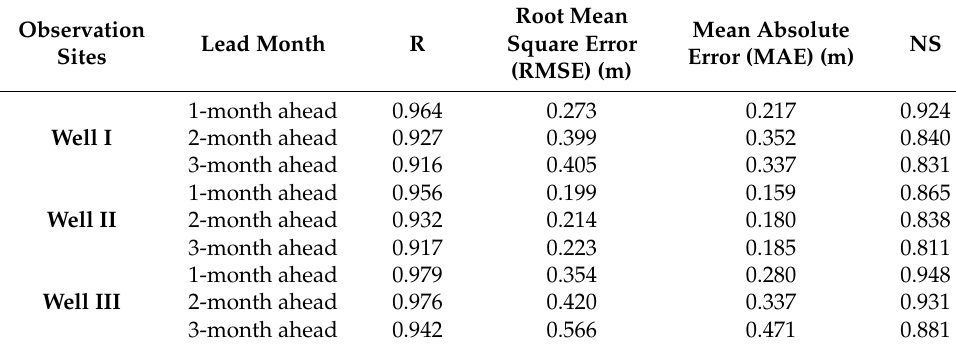
Table 3. Performance analysis of the VBELM models during testing periods for three